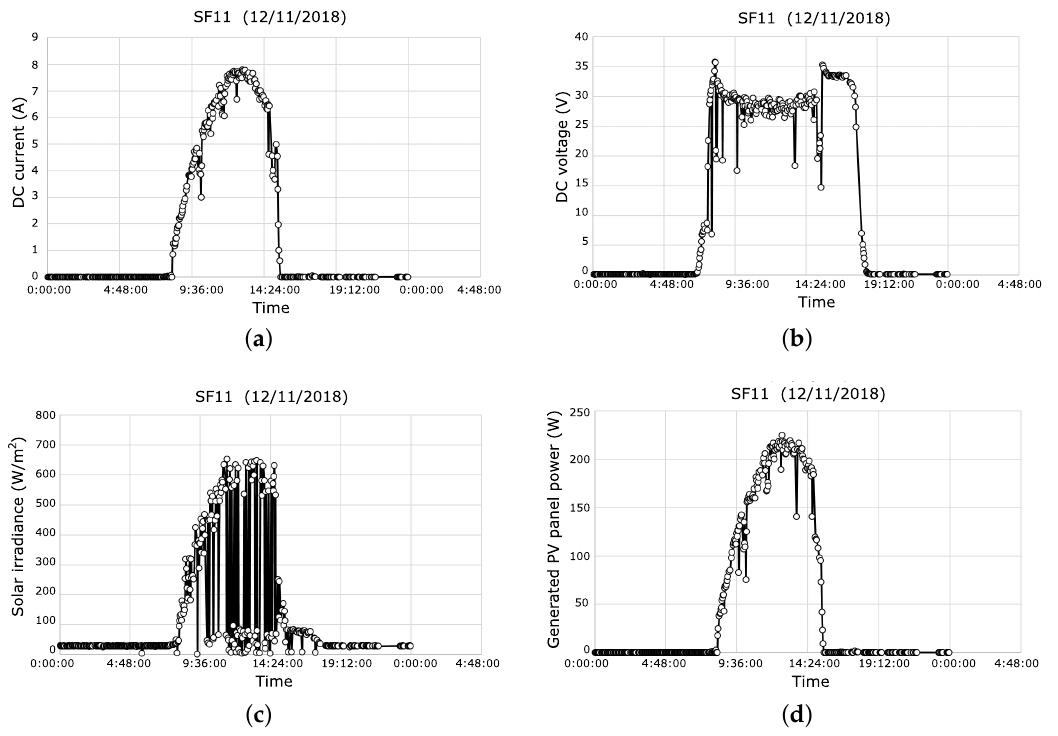
Figure 12. PV example of collected data (12 November 2018). ( a ) DC current data. ( b ) DC voltage data. ( c ) Solar irradiance data. ( d ) Generated active